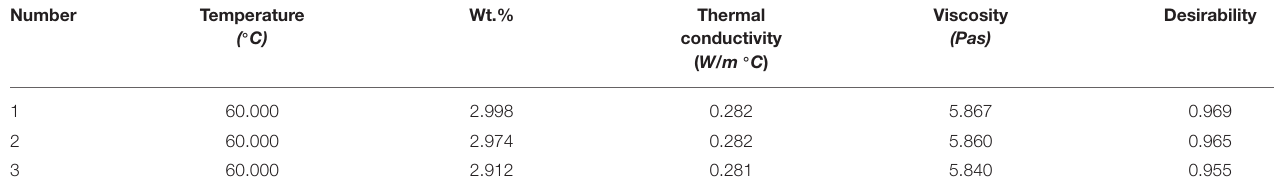
TABLE 5 | Multiple optimization